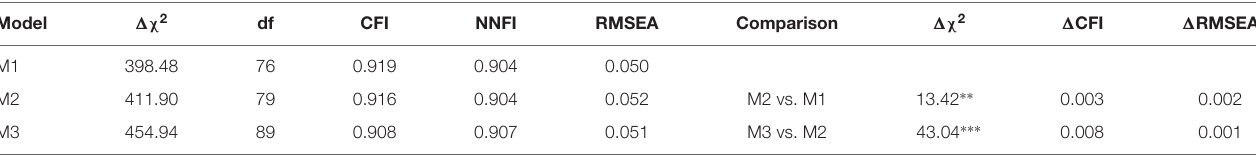
TABLE 2 | Model fit indices for measurement invariance across genders.